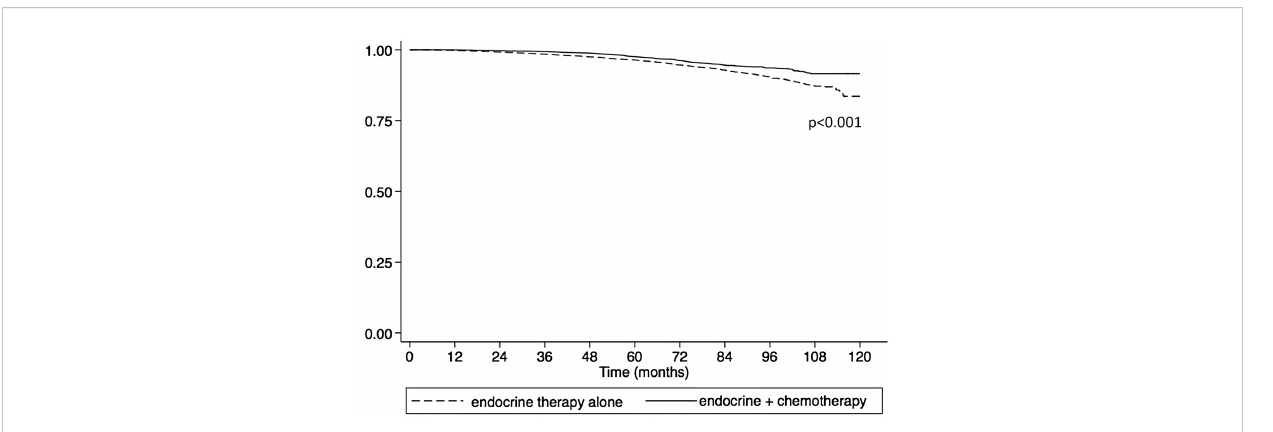
FIGURE 1 Overall survival compared between endocrine therapy alone versus endocrine therapy plus chemotherapy in pathological stage I-III HR+HER2- breast cancer patients with 1 – 3 positive nodes and RS 0-25. (OS at 3 and 5 years were 98.5% and 96.4% for the endocrine therapy alone cohort compared to 99.3% and 97.6%, respectively for the endocrine plus chemotherapy group